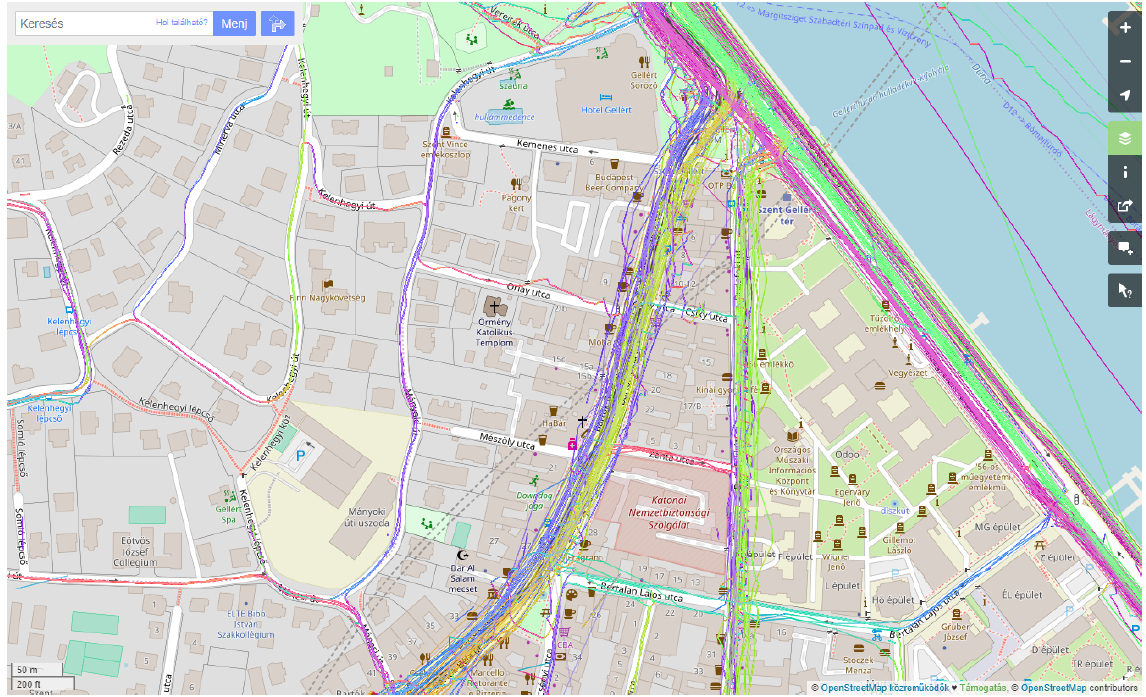
Figure 1. OpenStreetMap detail near to the Budapest University of Technology and Economics campus, Hungary. The color trajectories are from GPS, all the other parts (parcels, buildings, vegetation areas) from imagery